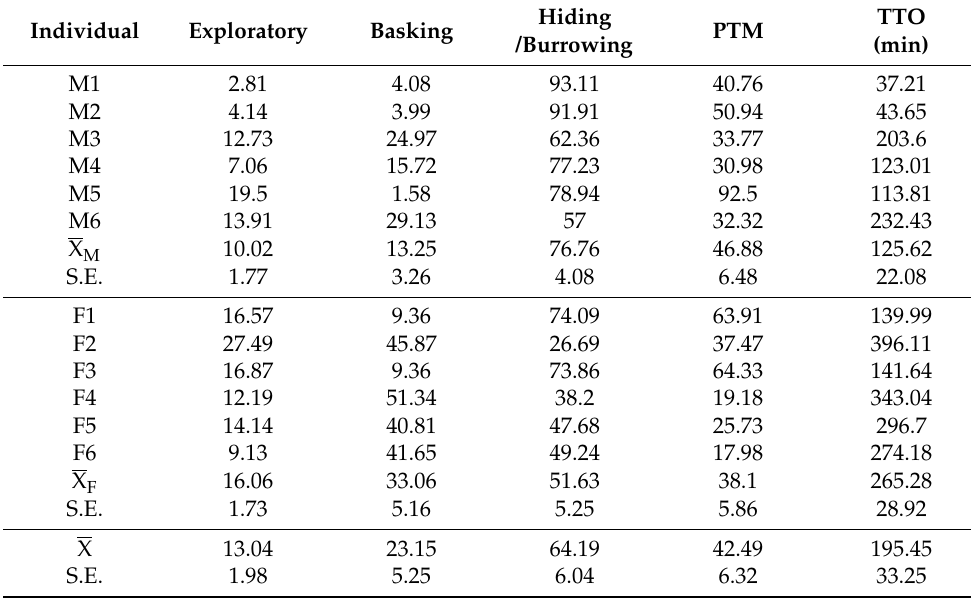
Table 2. Percentage of time used by males (M) or Females (F) during focal solitary observations. The total observation time is 9 h for each individual. The Exploratory and Inactive categories involve multiple behaviors enlisted in Table 1. S.E. is the Standard Error of the Mean. PTM. Percentage of time in movement. TTO. Total time